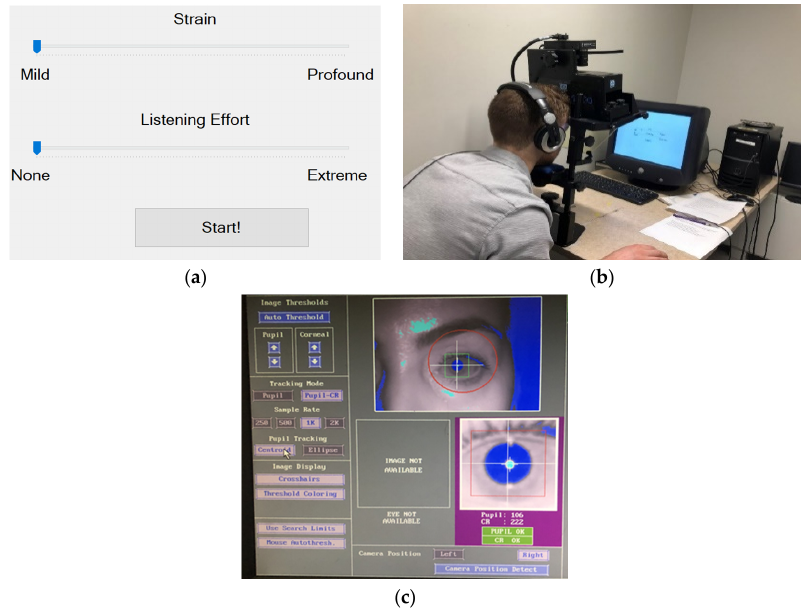
Figure 1. ( a ) Screenshot of the user interface for assessing the “strain” and “listening effort”